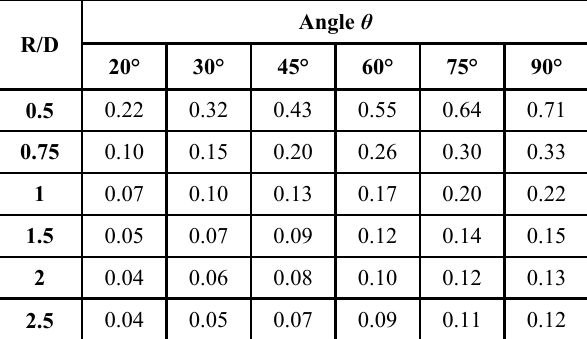
Table 4. The minor loss coefficients ξ for elbow with circular cross section from [8]